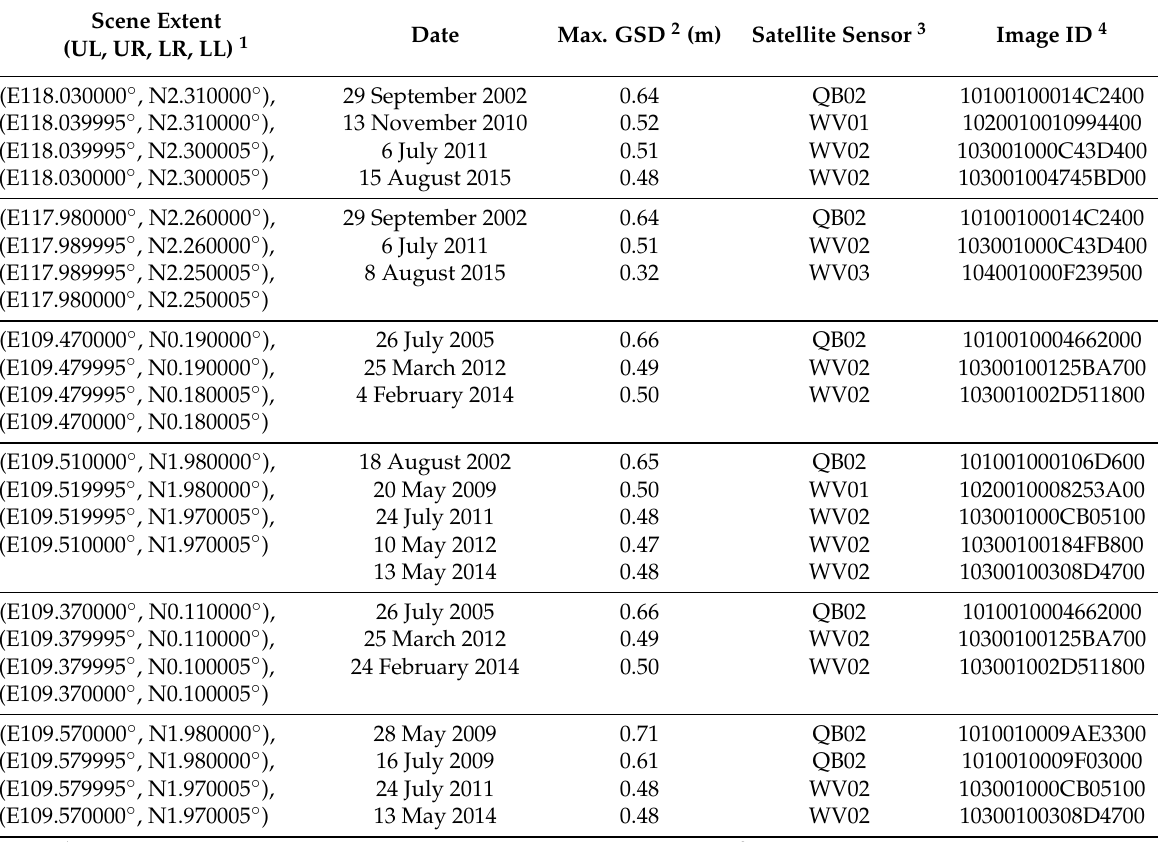
Table A1. List of very high spatial resolution (VHSR) images used in this study. The VHSR images were obtained through Digital Globe viewing